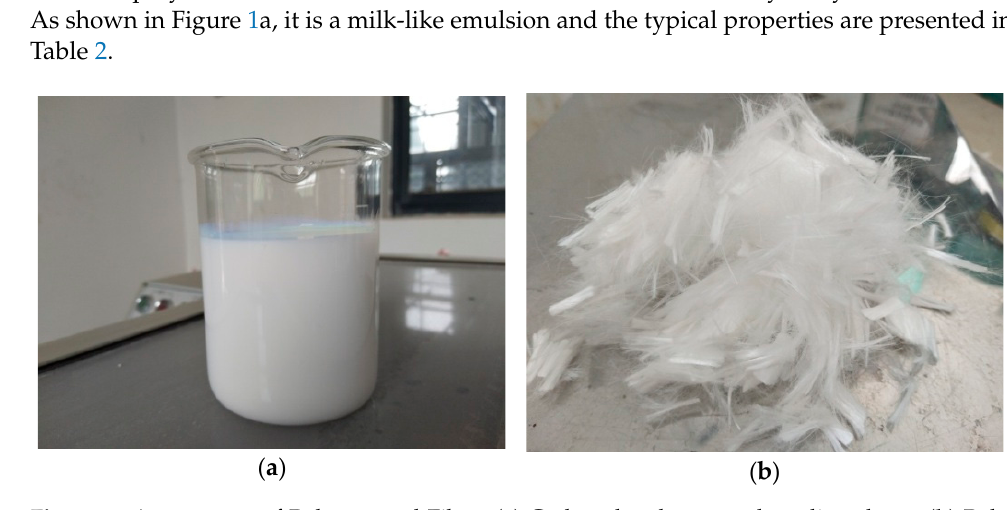
Figure 1. Appearance of Polymer and Fiber. ( a ) Carboxylated styrene–butadiene latex; ( b ) Polyformaldehyde fibers. Table 2. Properties of carboxyl butyl benzene